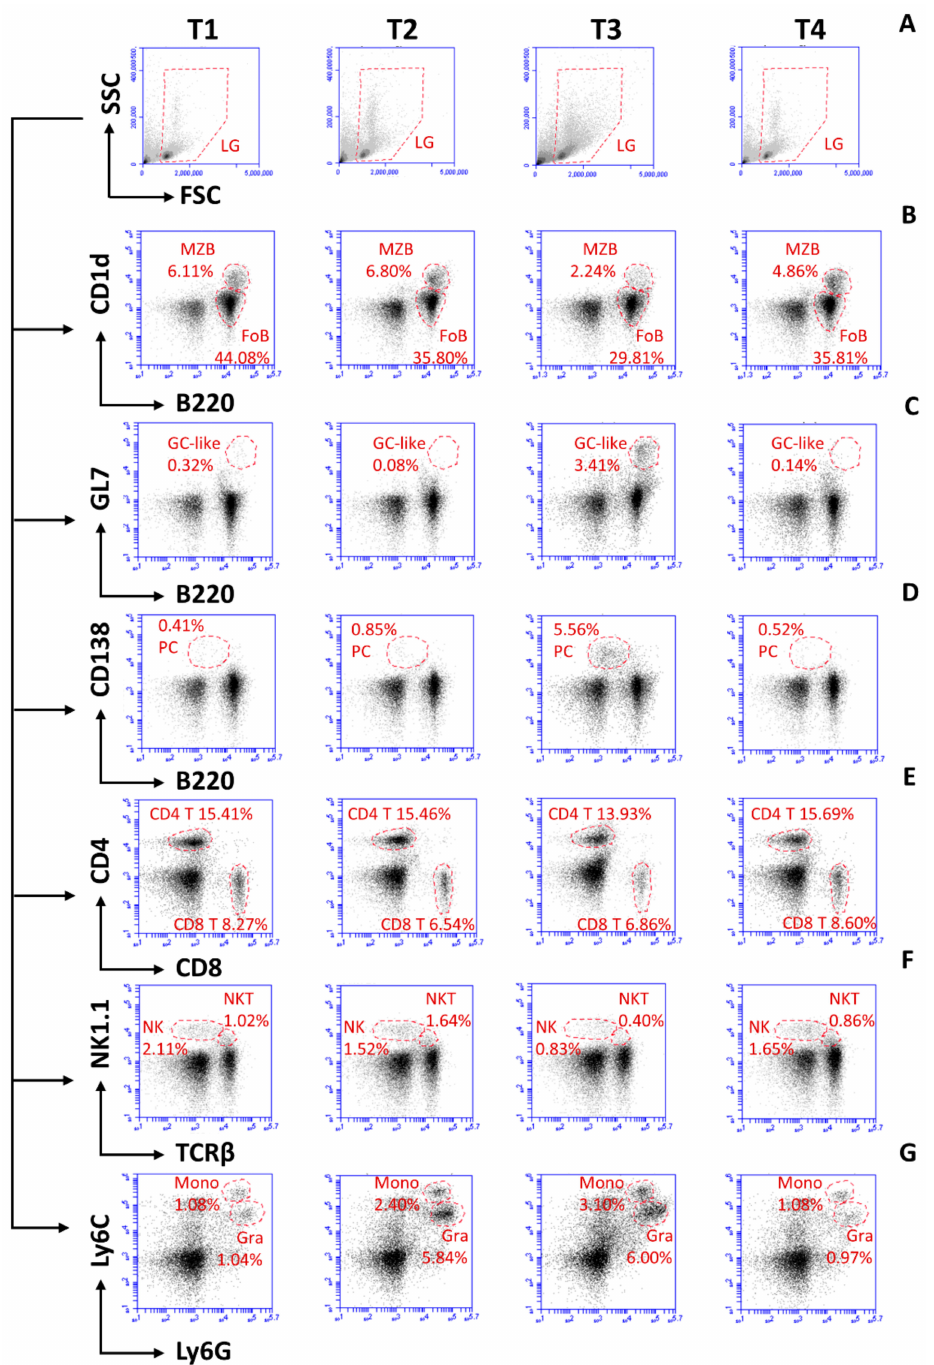
Figure 3. Early-stage T. b. brucei infection has a detrimental impact on the spleen composition in DTPa-vaccinated mice. Flow cytometry analysis of spleens of naïve mice (T1), DTPa-vaccinated mice prior to parasite challenge (T2), DTPa-vaccinated T. b. brucei AnTat 1.1-infected mice (T3), and DTPa-vaccinated T. b. brucei AnTat 1.1 challenged and cured mice (T4). Analysis was performed on ( A ) live-gated cells, identifying: ( B ) CD1d + marginal zone and CD1d - follicular B220 + B cells, ( C ) GL7 + B220 + germinal center-like B cells ( D ) CD138 + B220 Int plasma B cells, ( E ) CD4 + and CD8 + T cells, ( F ) NK1.1 + and NK1.1 + TcR β + cells, and ( G ) Ly6C Int /Ly6G High granulocyte and Ly6C High /Ly6G+ monocytes. One representative plot from a biological triplicate experiment is shown for each